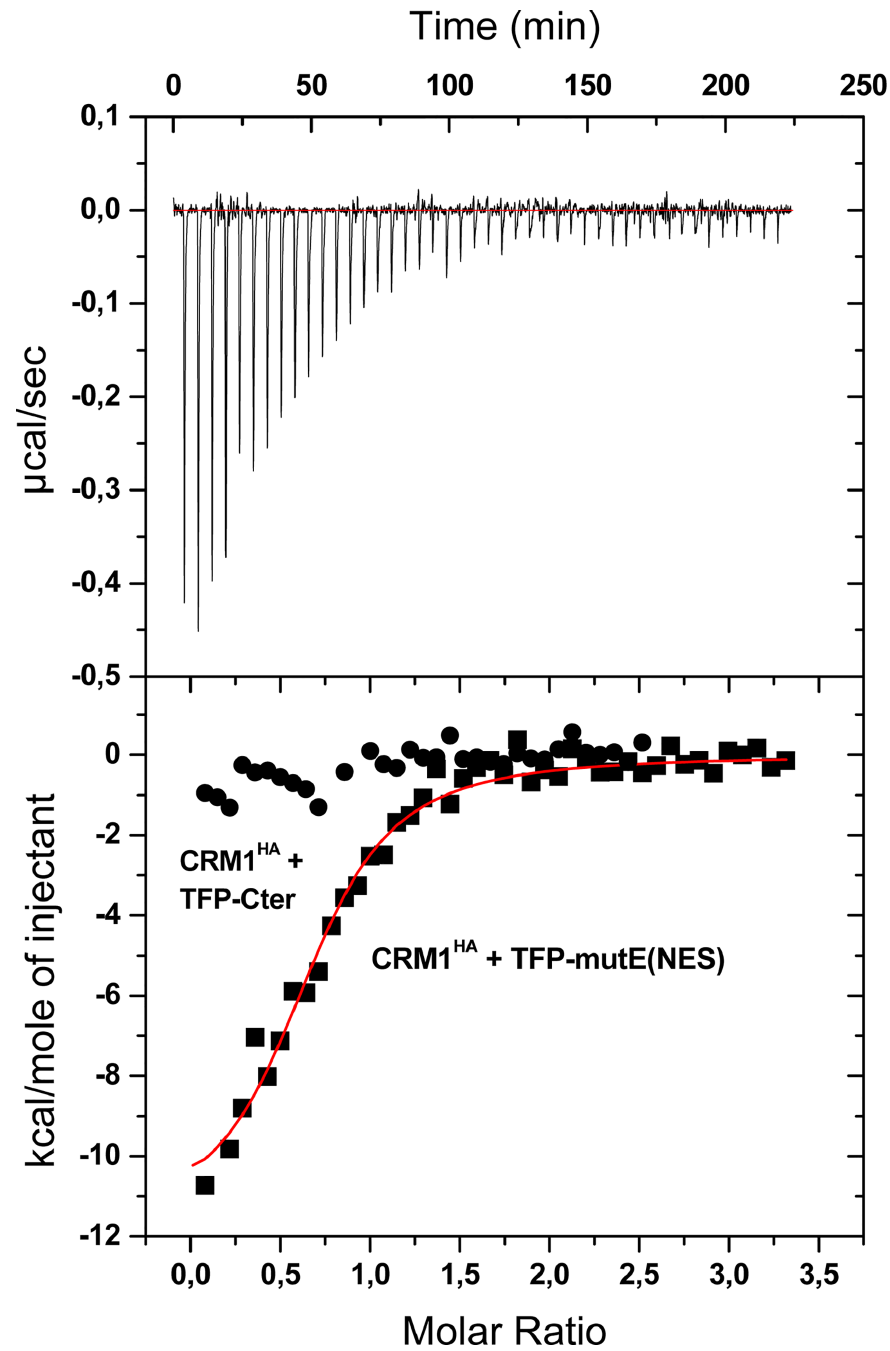
Fig 5. Analysis of CRM1 HA /TFP-NES interaction by ITC. Isothermal titration of CRM1 HA with TFP-mutE (NES). The upper panel shows the base line corrected instrumental response of successive additions of TFP- mutE(NES) (180 μ M) to CRM1 HA (13 μ M), at 20°C; the lower panel shows the integrated data (squares) and the fit of the binding isotherm by an independent binding sites model (solid line). χ 2 /DoF ( χ 2 divided by the degree of freedom) of the fitting was 7.38 x 10 4 . The titration of negative control TFP-Cter (180 μ M) onto CRM1 HA (14 μ M) (circles) is also shown for